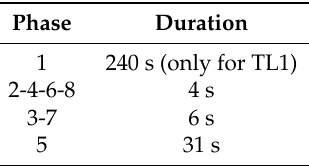
Table 2. TL cycle phases